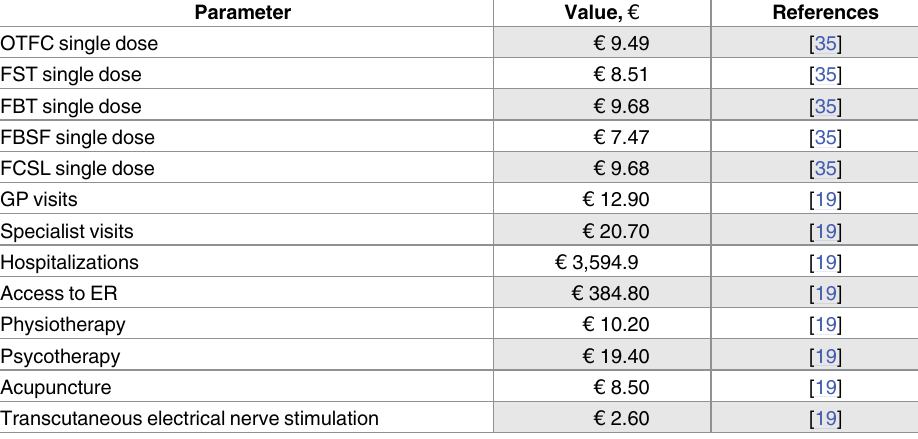
Table 3. Model parameters: Costs. Parameter Value, € OTFC single dose FST single dose FBT single dose € 9.68 FBSF single dose € 7.47 FCSL single dose